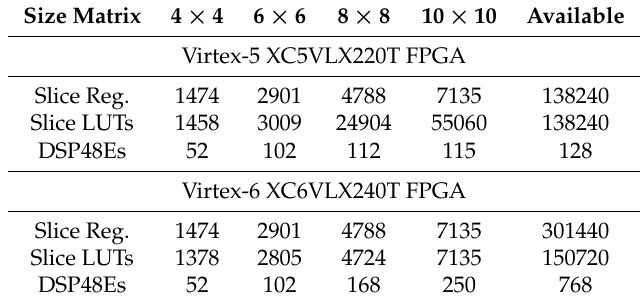
Table 1. Scalability of the matrix inversion architecture using different size matrices and Virtex FPGAs. Size Matrix 4 × 4 6 × 6 8 × 8 10 × 10 Available Virtex-5 XC5VLX220T FPGA Slice Reg. 1474 2901 4788 7135 138240 Slice LUTs 1458 3009 24904 55060 138240 DSP48Es 52 102 112 115 128 Virtex-6 XC6VLX240T FPGA Slice